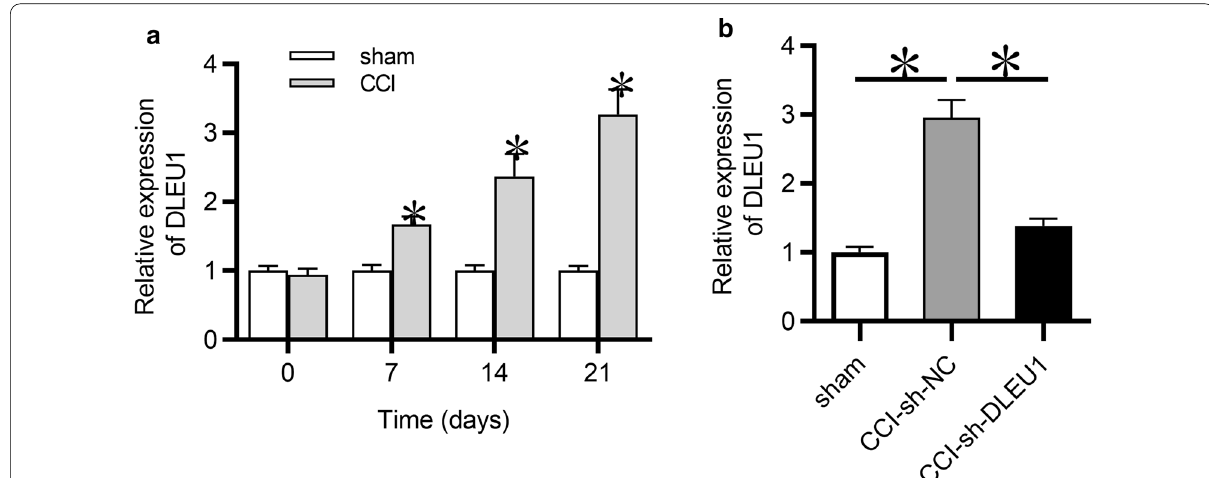
Fig. 1 DLEU1 was upregulated in CCI rats. a DLEU1 expression in the dorsal spinal cord of rats was detected by RT-qPCR analysis at postoperative days 0, 7, 14 and 21. N 8 for each group. b Expression of DLEU1 in CCI rat models infected with lentivirus carrying sh-DLEU1 or sh-NC at = postoperative day 7 was detected by RT-qPCR analysis. N 8 for each group. *p < =